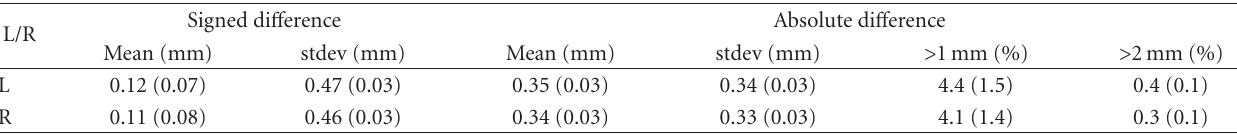
Table 3: Intermethod accuracy analysis: summary of the group-average statistics for di ff erence in cortical thickness measurement between DELFMAP and